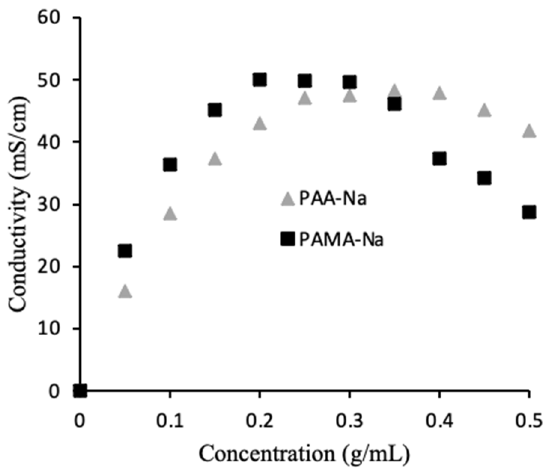
Figure 3. Effect of polymer concentration on draw solution conductivity.